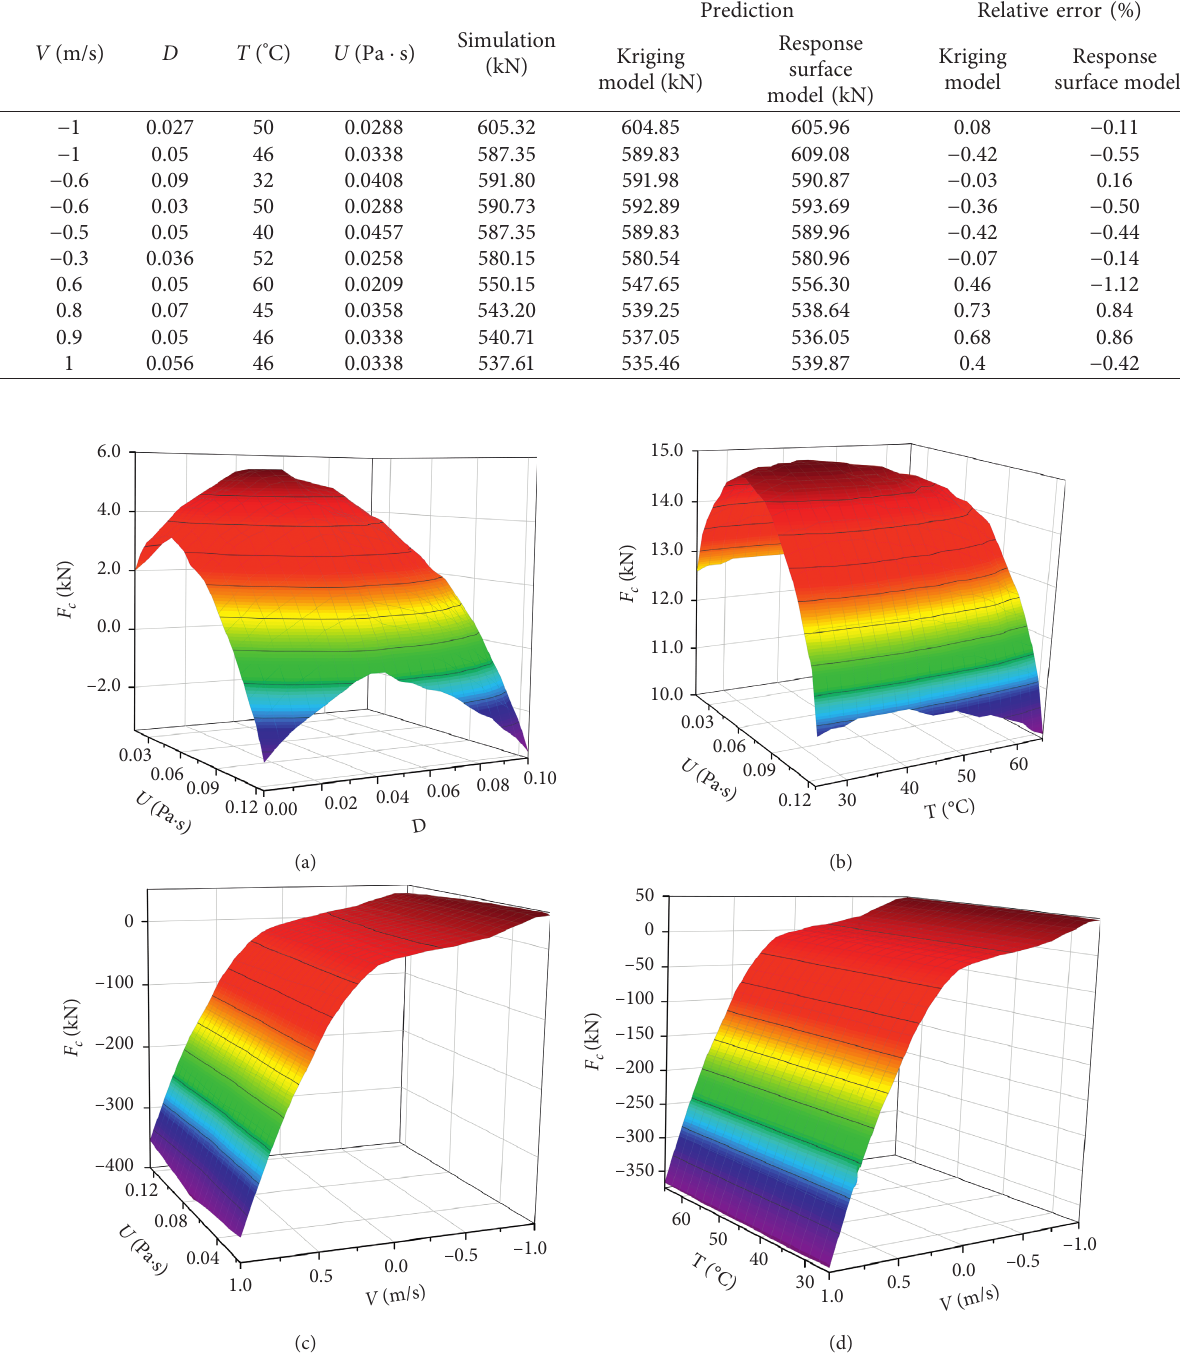
Figure 14: Surrogate models of the relationship between (a) damping force, oil viscosity, and gas dissolution rate; (b) damping force, temperature, and oil viscosity; (c) damping force, suspension vibration speed, and temperature; and (d) damping force, suspension vibration speed, and oil viscosity.